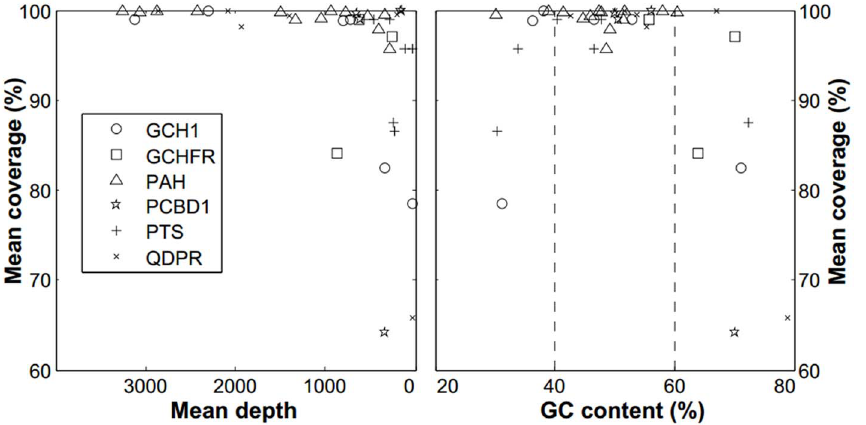
Figure 4. Comparison of GC content, read depth and coverage. The relationship between mean read depth and mean coverage (left) and the relationship between GC content and mean coverage (right) in each exon of the PAH, GCH1, QDPR, PTS, PCBD1 and GCHFR genes. Exons with low coverage have relatively low read depth and excessively low (less than 40%) or high (more than 60%) GC content.